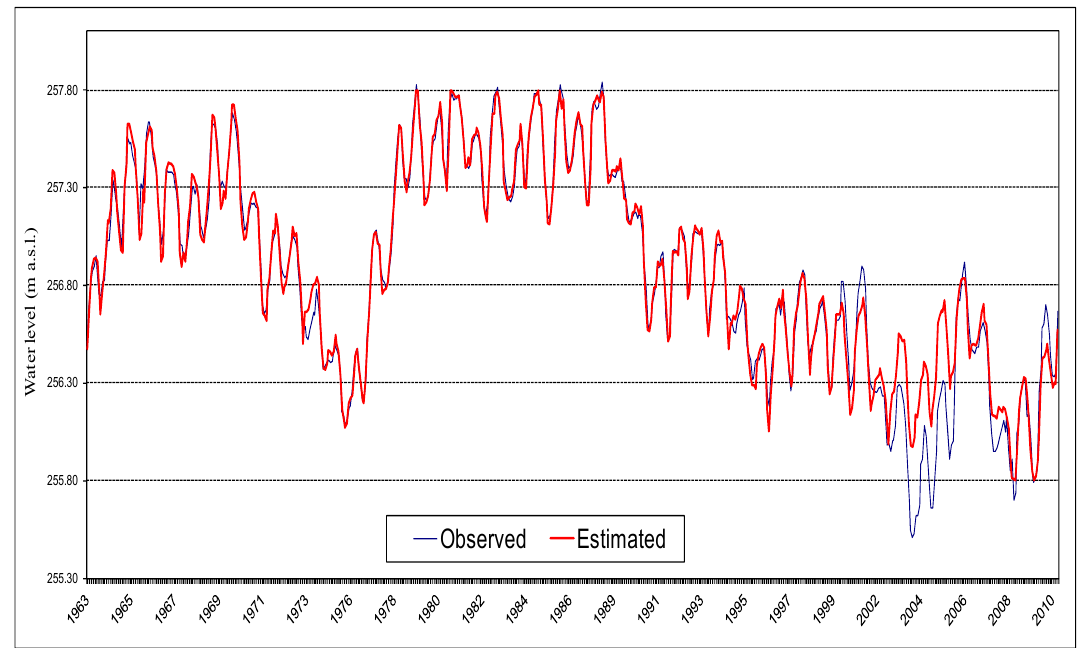
Figure 9. Estimated and observed Lake Trasimeno levels during the calibration phase (1963–1999) and the validation phase (2000–2010).